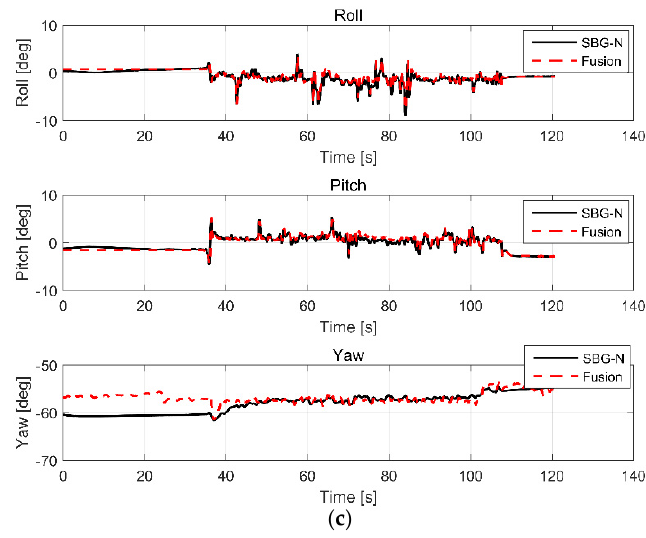
Figure 3. Comparison of multi-sensor data fusion (MSDF)-based estimation and high-precision sensors in an outdoor environment. ( a ) Contrast between the position estimations of the real-time kinematics (RTK) and fusion-based systems; ( b ) Contrast between the velocity estimations of the RTK and fusion-based systems; ( c ) Contrast between the attitude estimations of the IMU (SBG-N) and fusion-based systems. The red line represents the fusion data and the black line represents the ground truth, which was provided by the RTK system or the high-precision inertial measurement unit (IMU). It can be seen from Figure 5 that the satellite signal is good between 0 and 300 s. The position estimated by the fusion algorithm is consistent with the position estimated by the RTK